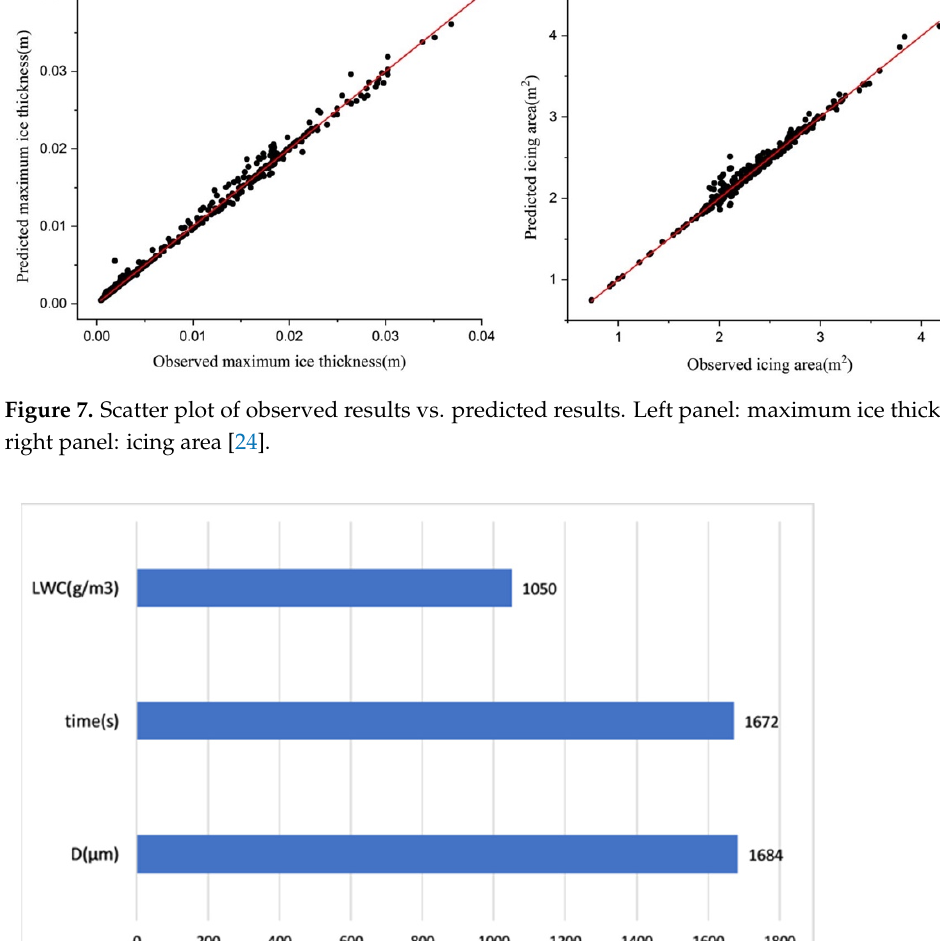
Figure 7. Scatter plot of observed results vs. predicted results. Left panel: maximum ice thickness; right panel: icing area [24].